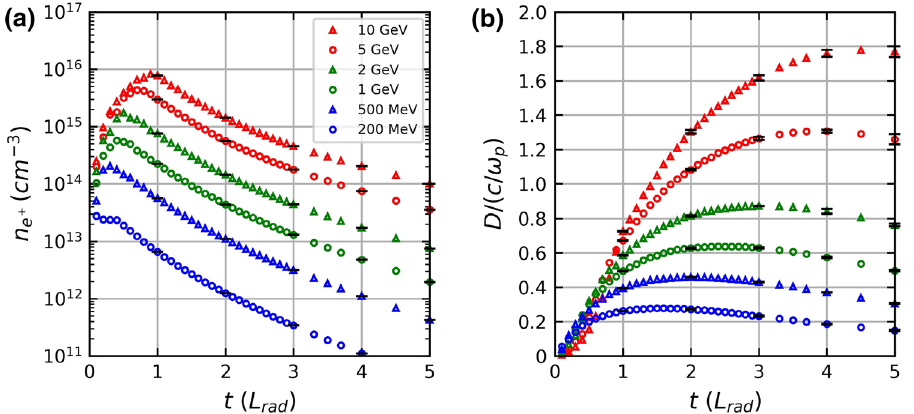
Figure 7. ( a ) Densities of positron beams are shown as functions of the lead converter thicknesses for different driver electron beam energies of 200 MeV, 500 MeV, 1 GeV, 2 GeV, 5 GeV, and 10 GeV. ( b ) D/(c /ω p ) values of the positron beams are shown as functions of the lead converter thicknesses for different driver electron beam energies from 200 MeV to 10